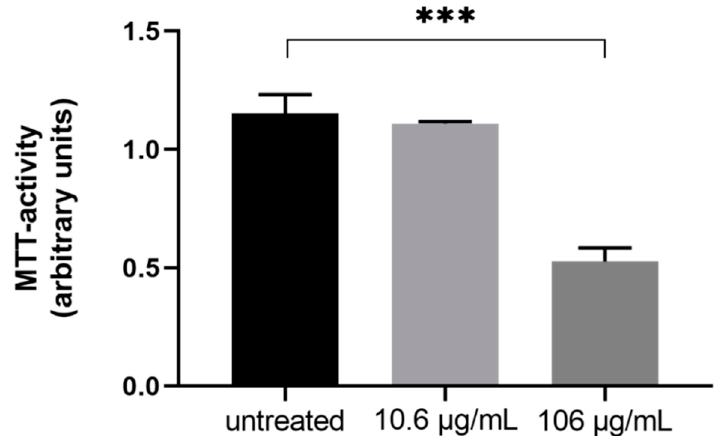
Figure 1. The di ff erences in cell viability as assessed by dimethyl thiazolyl diphenyl tetrazolium bromide (MTT)-assay of immortalized human liver cells (HepG2) after three days treatment with di ff erent concentrations of tigecycline ( n = 3).